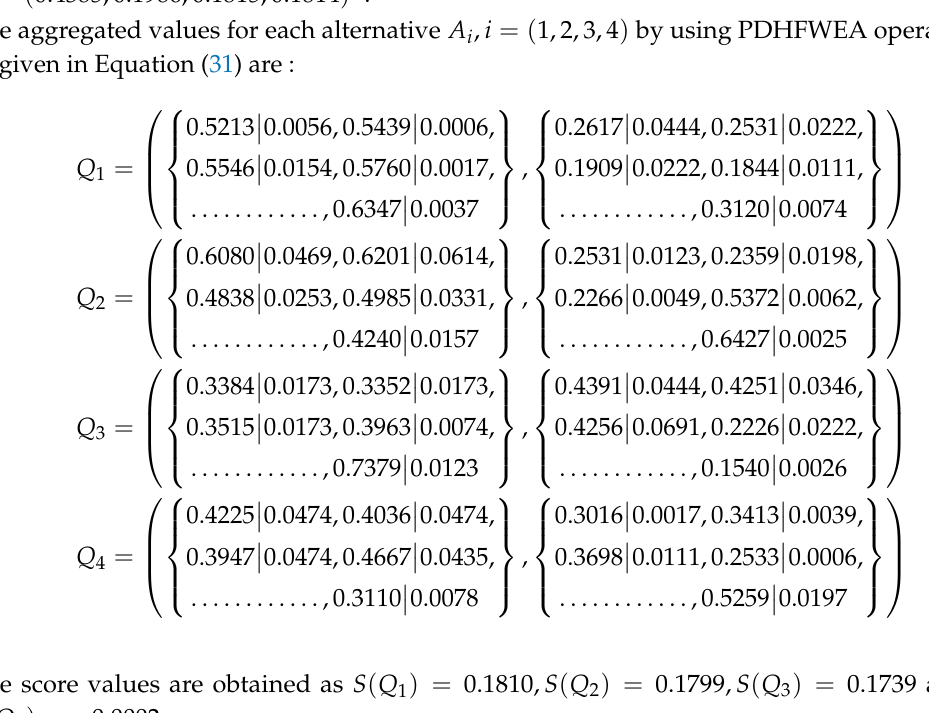
the weights are determined